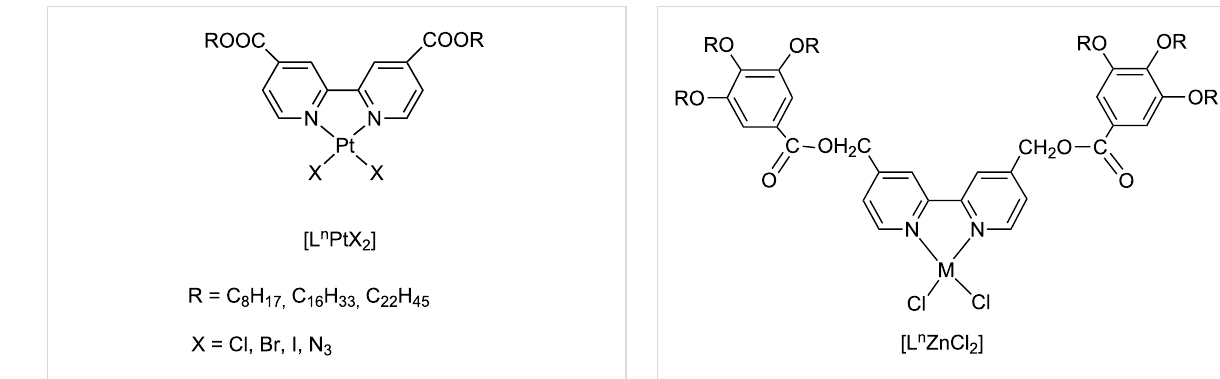
coordination chemistry in the metal-mediated formation of liquid crystals. Indeed the induction of a dipole moment upon coordination with an MX 2 moiety, allowed most of the half-disc shaped complexes [L n PtX 2 ] (Figure 4) to self-assemble into full disc shaped dimers as described by the complementary shape approach [52].